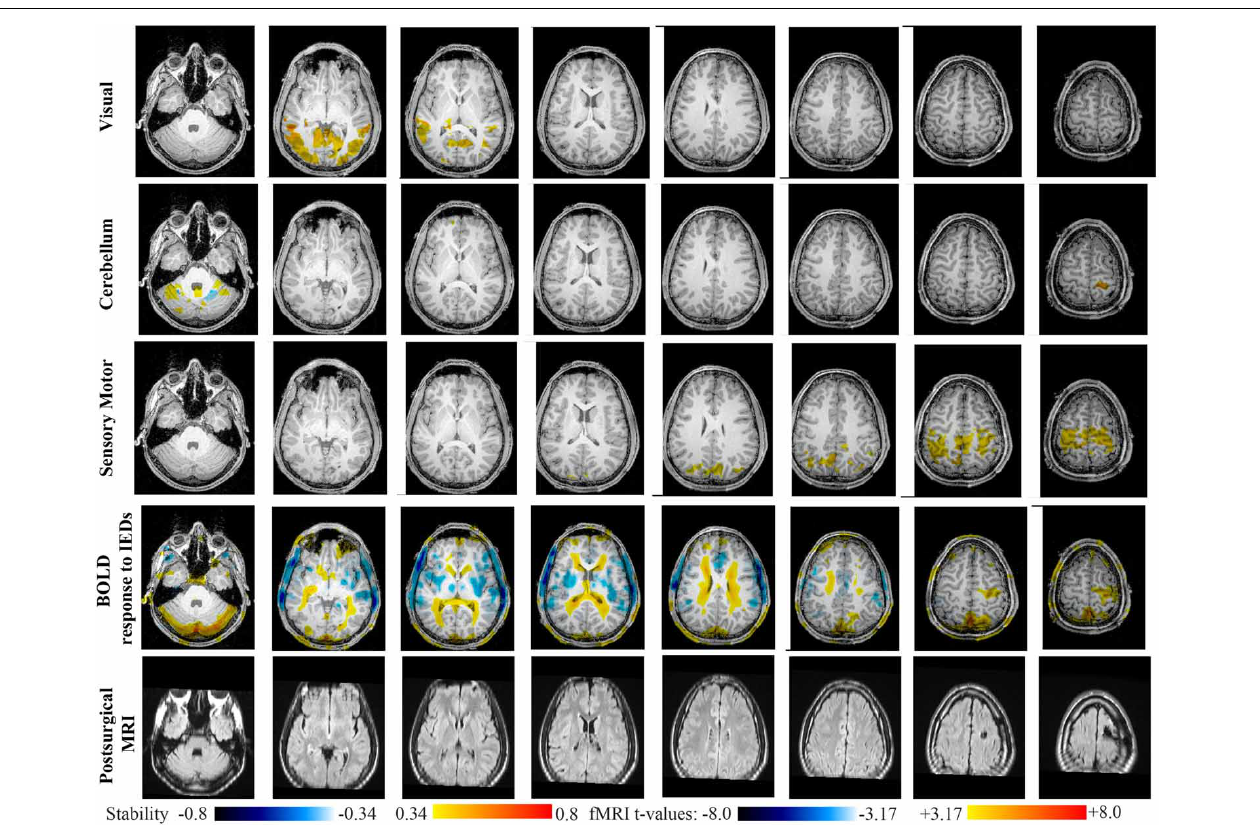
FIGURE 11 | Evaluation of DANI on Patient 6 with right frontal FCD. Results are presenting most salient stability changes observed in Cmap n followed by a t -map of the BOLD response to epileptic discharges and a postsurgical FLAIR MRI, all resampled in the native anatomical MRI space of the patient.